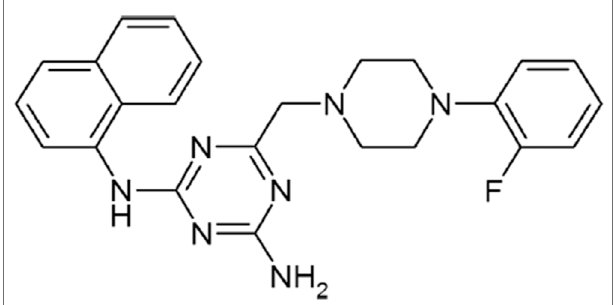
FIGURE 1 | Chemical structure of FPMINT.